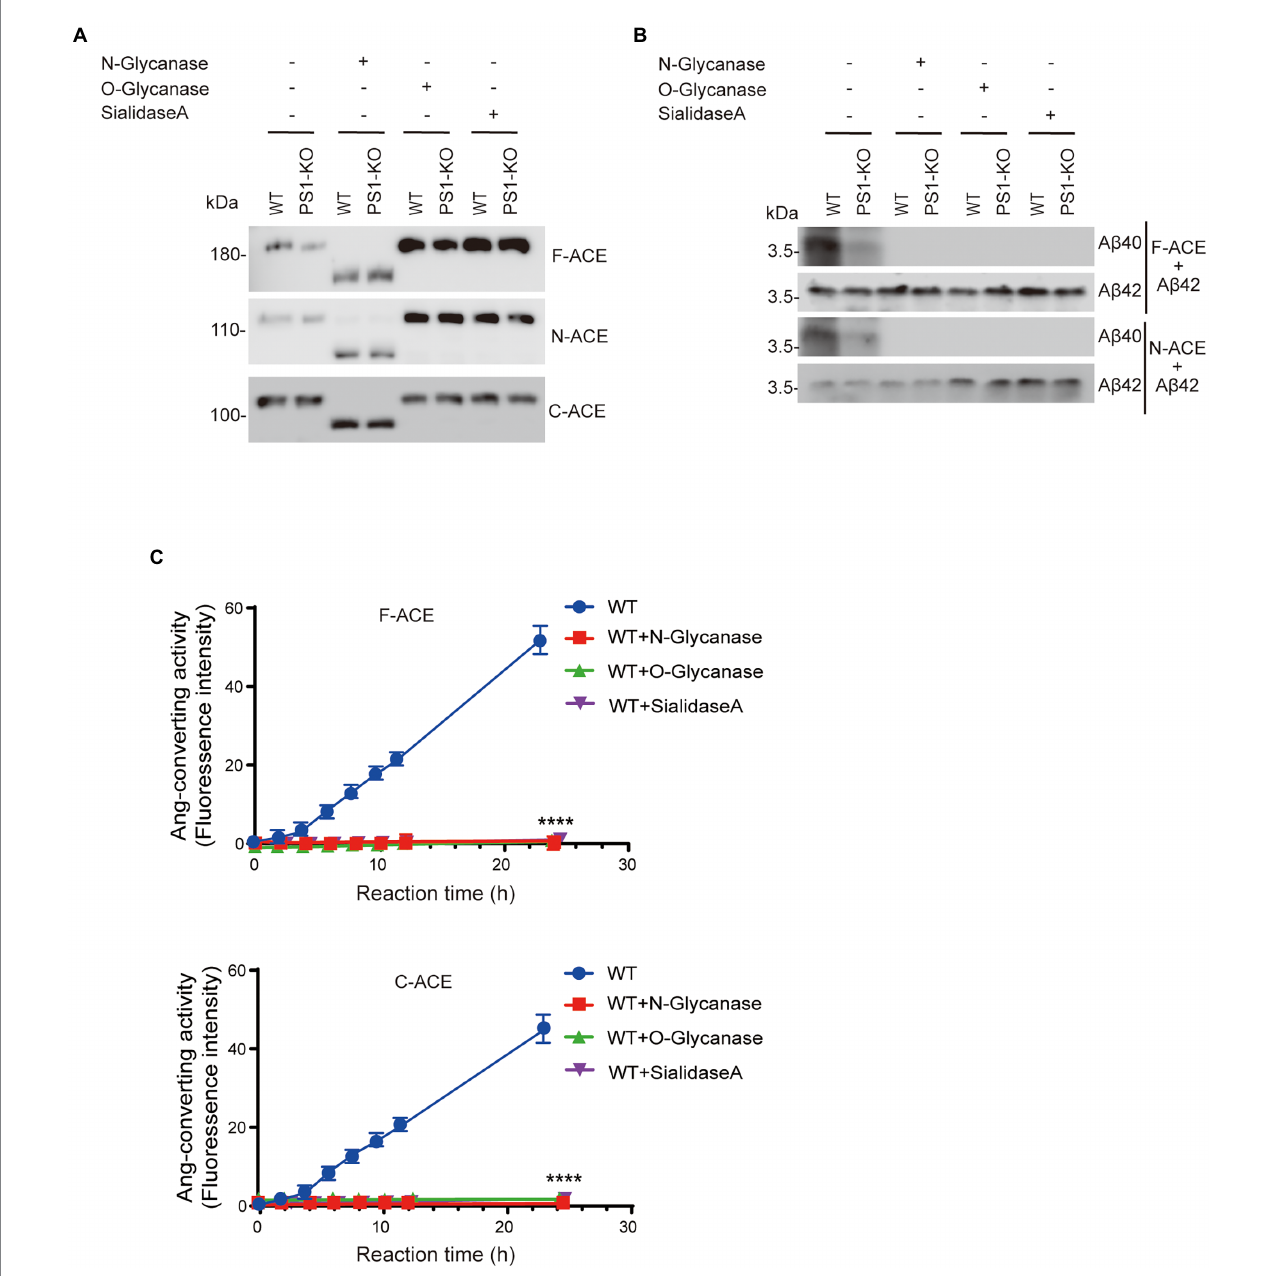
FIGURE 6 De-glycosylation abolished the A β 42-to-A β 40– and angiotensin-converting activity of ACE. (A) Purified F-ACE, N-ACE, and C-ACE (30 μ g each) from WT and PS1-KO fibroblasts was de-glycosylated using 1 μ l of N -glycanase, O -glycanase, or sialidase A for 2 h at 37 ° C. Western blots of 20 μ g of de-glycosylated F-, N-, or C-ACE proteins from WT or PS1-KO fibroblasts were probed with an anti–6 × His-tag antibody. (B) De-glycosylated F-ACE and N-ACE proteins were mixed with synthetic A β 42 and incubated at 37 ° C for 2 h. Western blots of the mixtures were probed with anti-A β 40 and anti-A β 42 antibodies. F-ACE and N-ACE did not exhibit A β -converting activity after de-glycosylation using N -glycanase, O -glycanase, or sialidase A. (C) F-ACE and C-ACE did not exhibit Ang-converting activity after de-glycosylation using N -glycanase, O -glycanase, or sialidase A. Values represent the mean ± SD; n = 3; ****, p < 0.0001, Holm-Sidak’s multiple comparisons